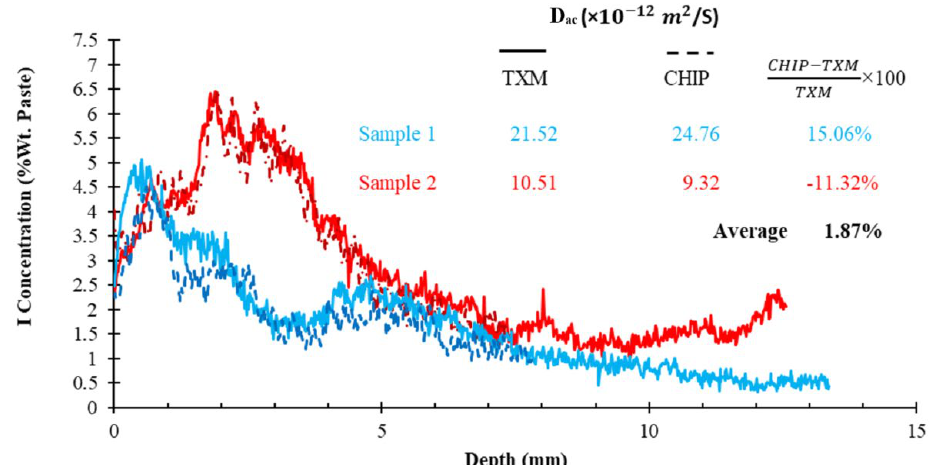
10 Figure 8. Comparing the TXM and CHIP results for paste samples with different w/cm ratios. The 12 concrete samples were tested with both CHIP and TXM, and Figure 9 shows the concentration profiles of the two samples in both methods. The other results can be